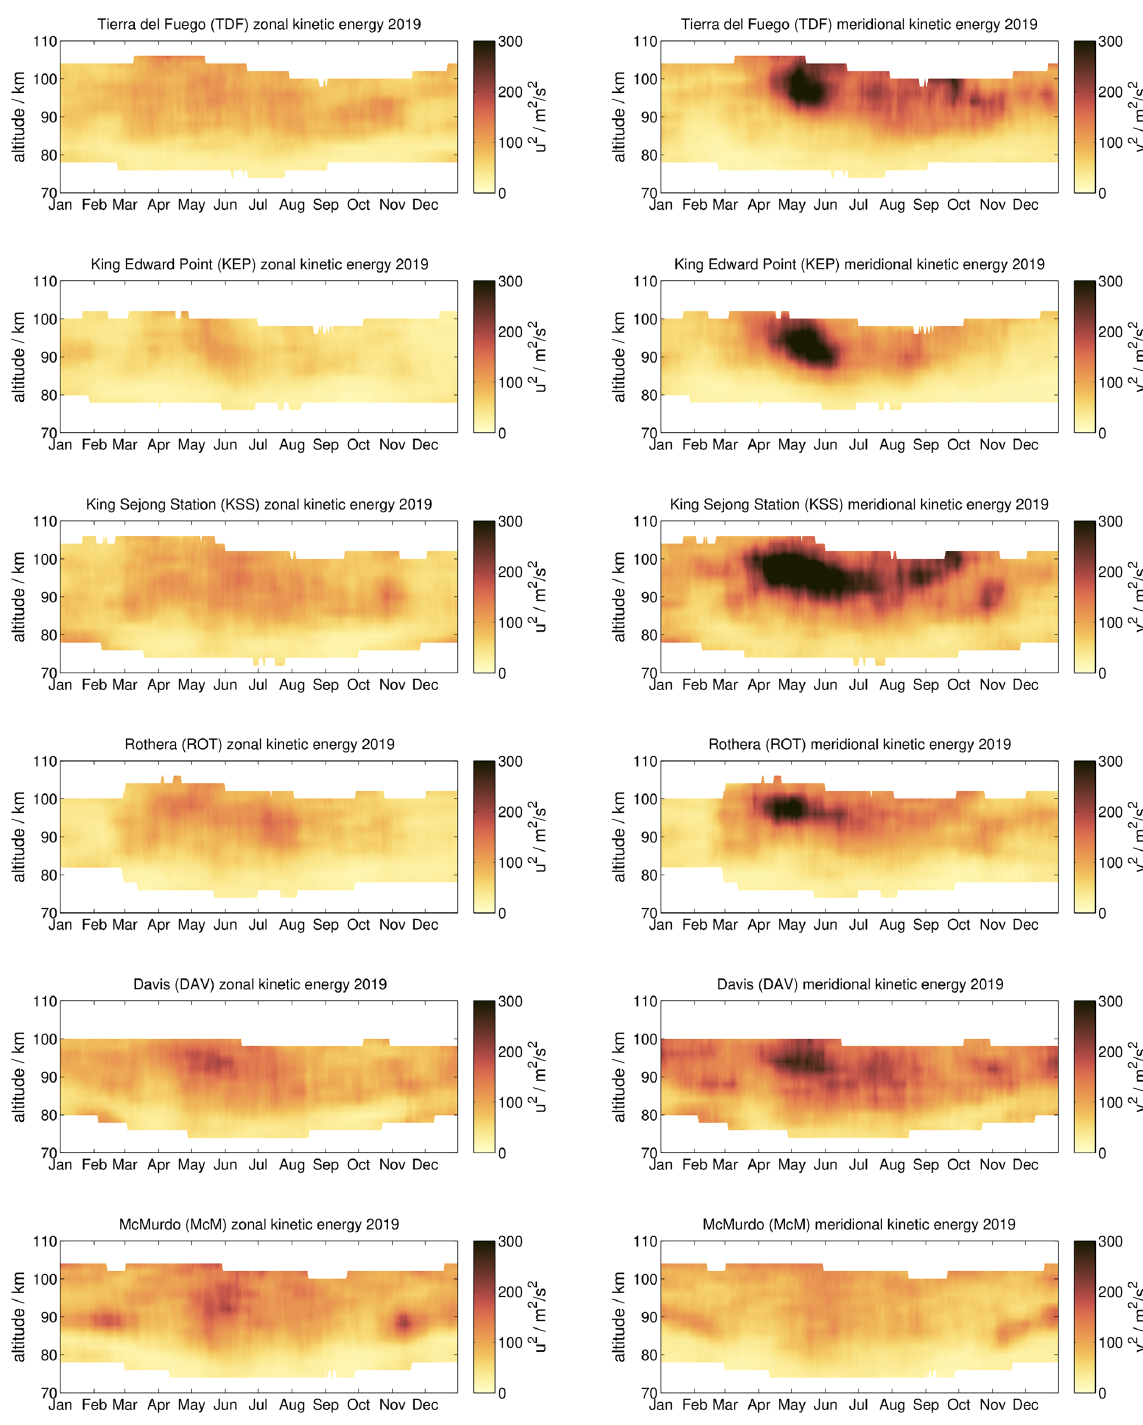
Figure A2. Kinetic gravity wave energy as determined for the re- solved waves from the ASF for each station during the year 2019. Same as Fig.